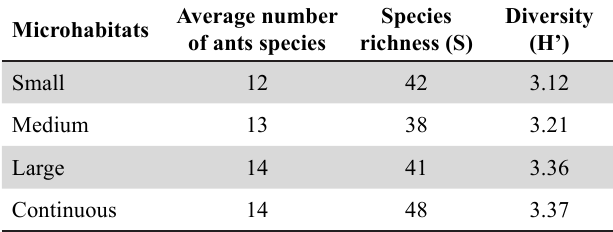
Table 3 . Average number of species per sample point, Species rich- ness (S) of ants and ants Shannon diversity (H’) in the four different microhabitats.